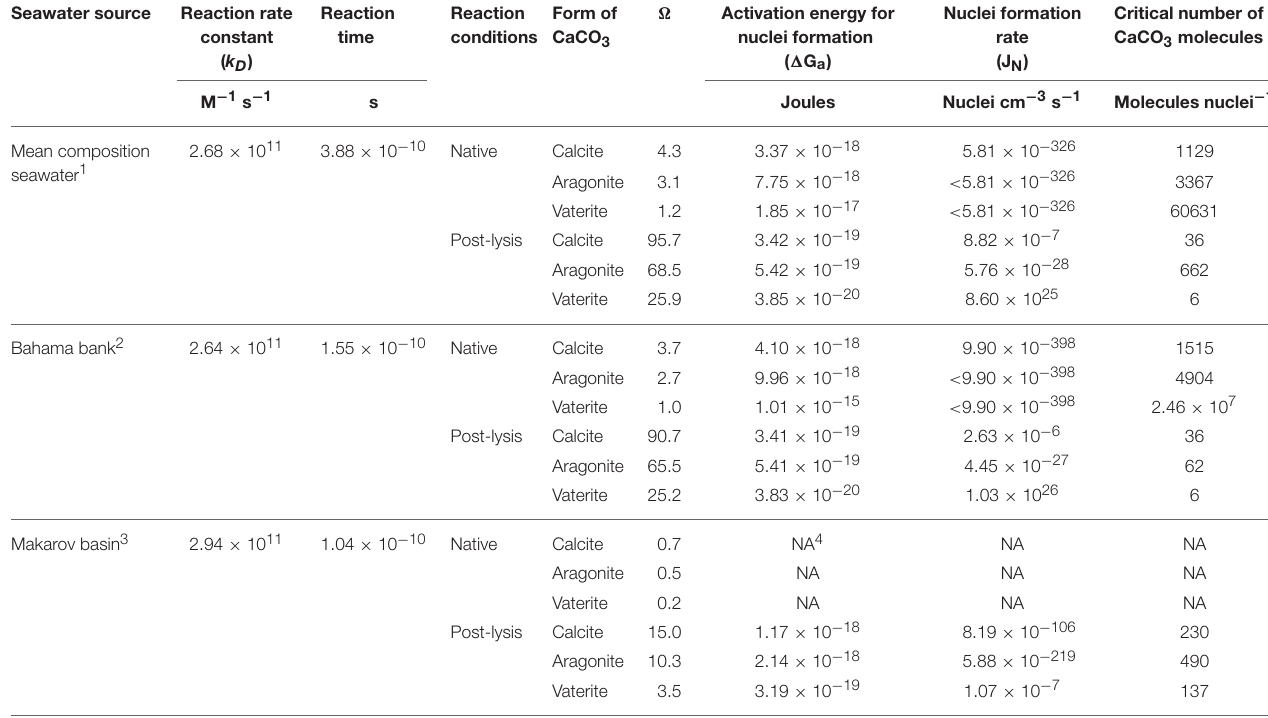
TABLE 1 | Data on the homogeneous nucleation of CaCO 3 in seawater from different